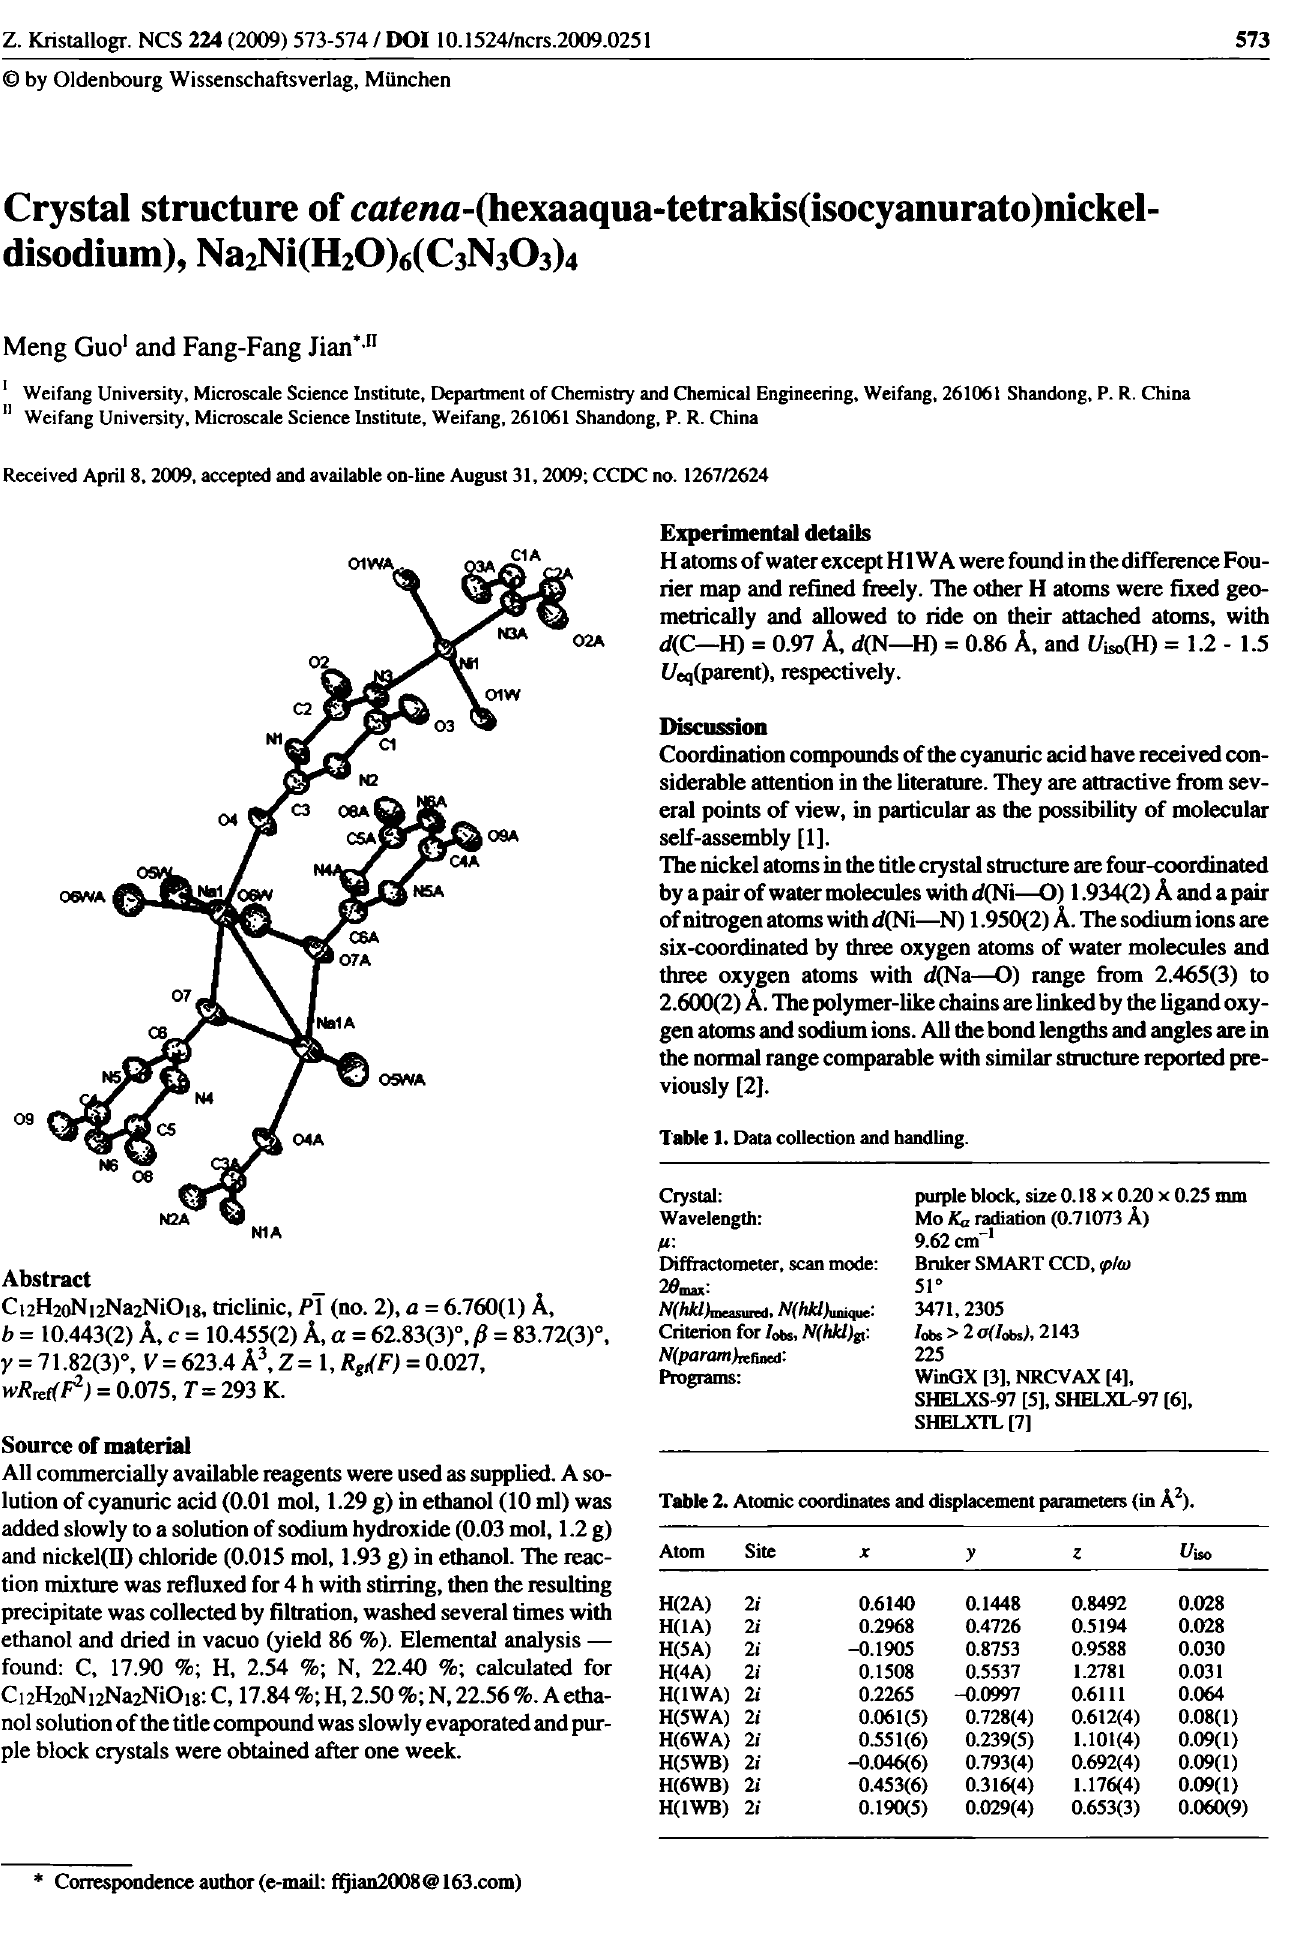
Table 2. Atomic coordinates and displacement parameters (in Â 2